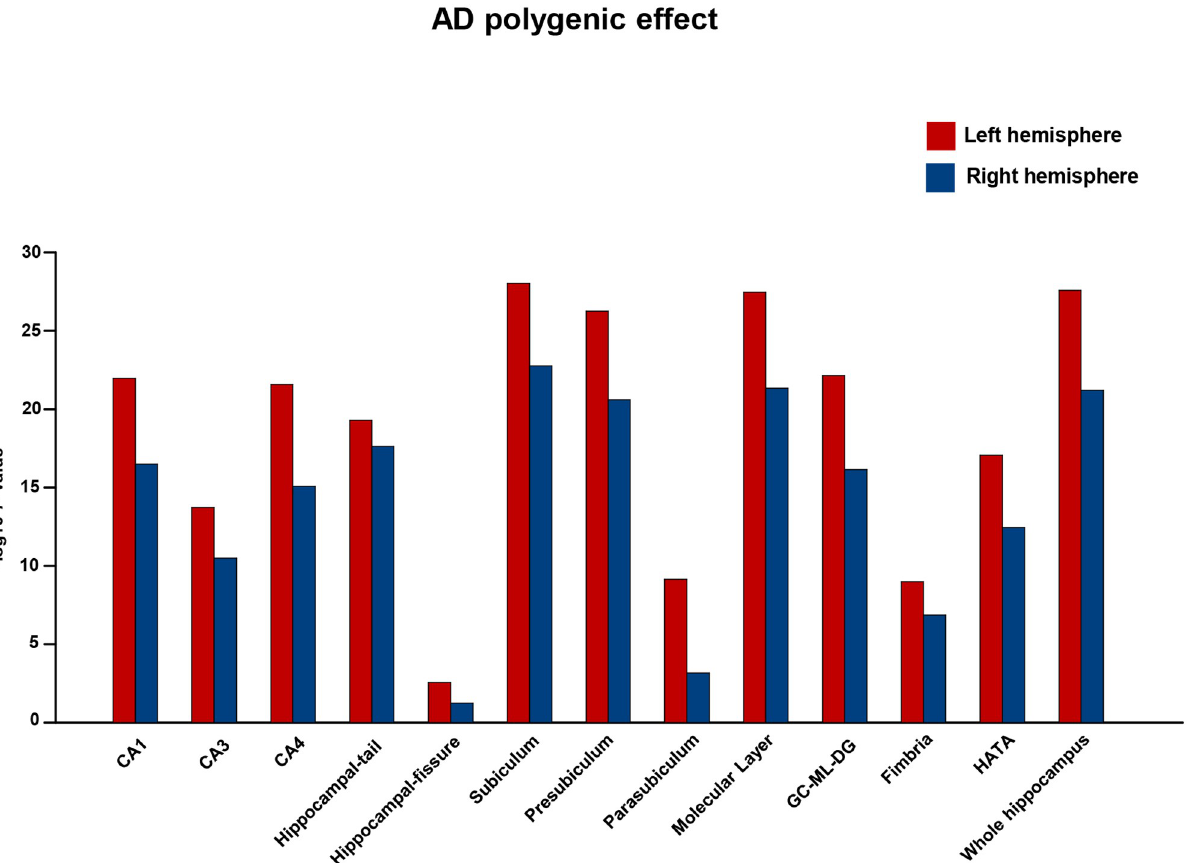
Fig 2. Hippocampal subfields exhibit asymmetric hemispherical effects for AD PGRS. AD polygenic analysis on hippocampal subfields showed asymmetric hemispherical differences. Best fit AD polygenic risk score correlation P -values were shown for each hippocampal subfield. The x-axis shows hippocampal subfields and the y-axis shows–log10 P -values from the best-fit AD polygenic risk score correlations. The red-colored bar plot indicates the left hemisphere and the blue color indicates the right hemisphere.